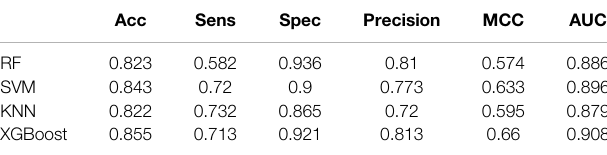
TABLE 4 | Comparison of six performance evaluations on the training